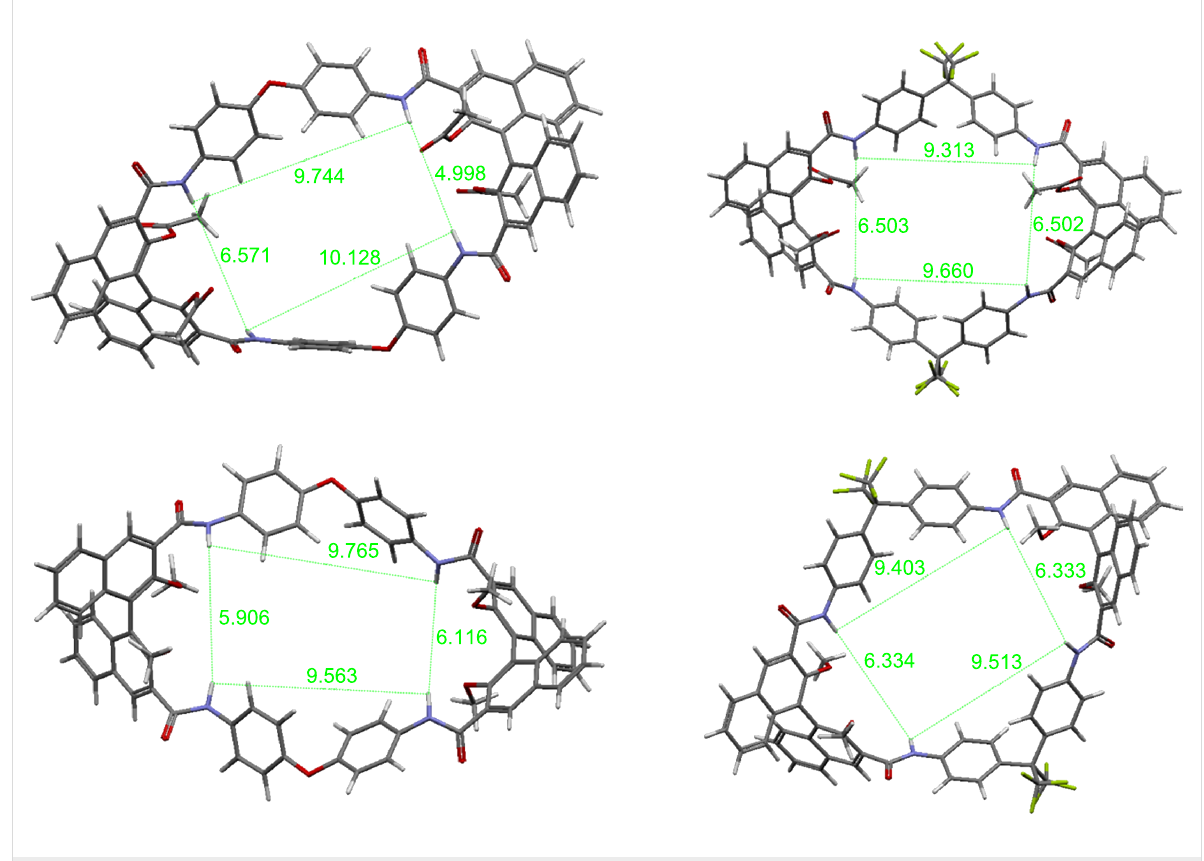
Figure 3: Minimized molecular structures of (from top left to bottom left, clockwise): ( R , R )- 10 , ( R , R )- 11 , ( R , R )- 13 and ( R , R )- 12 (distances between the H atoms of the NH amide groups are given in angstroms).